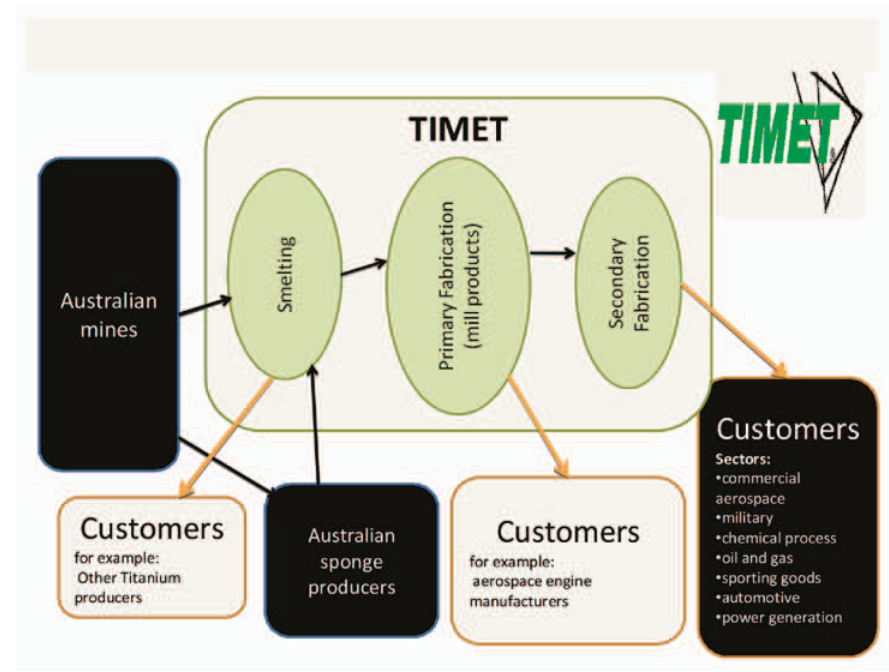
Figure 3: TIMET’s supply chain with plants located in South Africa and China